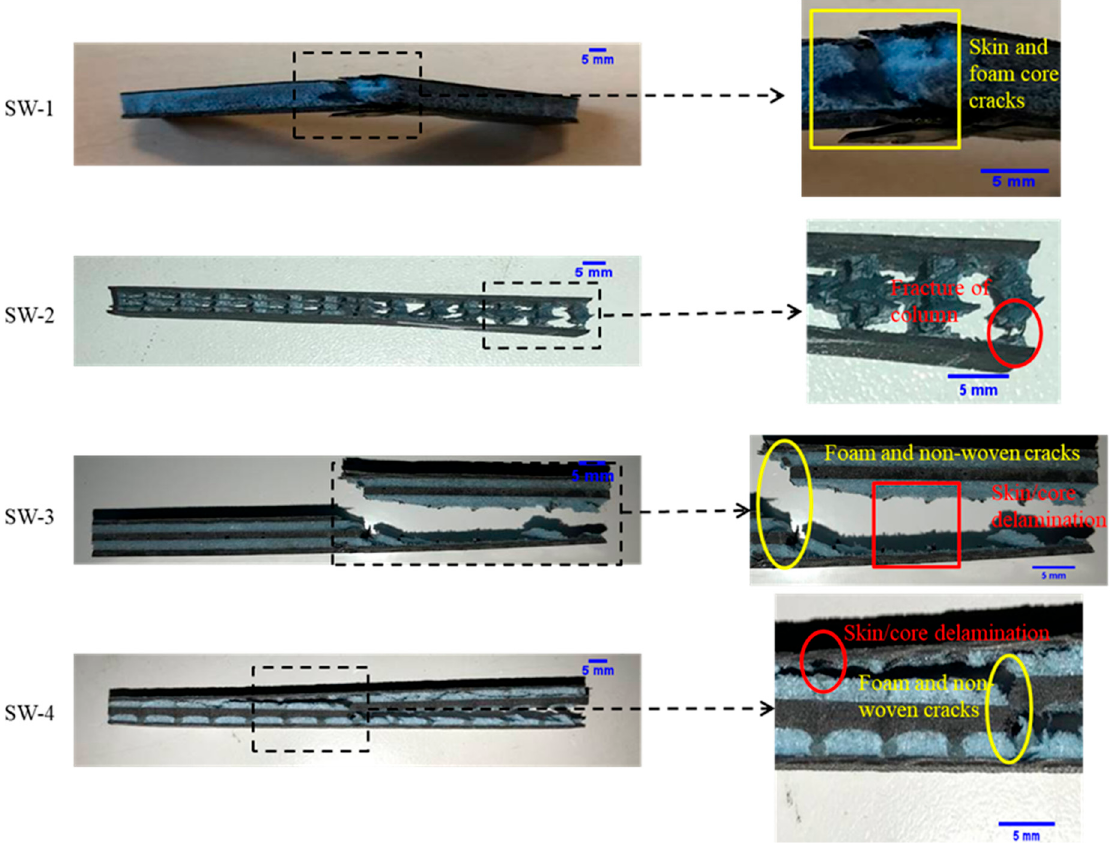
Figure 8. Fractured specimens after the Charpy impact test.